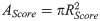
Volumes of neuronal compartments, particle beam and scoring.(A) At each trial, a random particle beam enters at a random point on xy-plane and propagates along the +z-direction. The neuron is bounded by the volume Cyl
Neuron and embedded on a larger scoring volume Cyl
Score. L
Score is the height of the Cyl
Score and randomly selected 20 μm tracks from the irradiation library are lined up to create a particle beam equal or larger than L
Score. The constant distances between the cylinders L
Forward, L
Backward and R
Gap contribute to the electronic equilibrium in Cyl
Neuron. L
Neuron is the maximum extension of the neuron along the z-axis and changes at each trial with random orientation of the neuron. Particle fluence is calculated as 1/A
Score where AScore=πRScore2. If there are one or more coincidence events, then the trial is recorded as a ‘hit’. For clarity, only one out of twenty voxels are shown for a 56Fe beam at 600 MeV/u in (A) and 20 nm3 voxels are shown much larger than their actual size on the panels. (B) A close up view of 12C at 300 MeV/u which is grazing the dendritic branches.